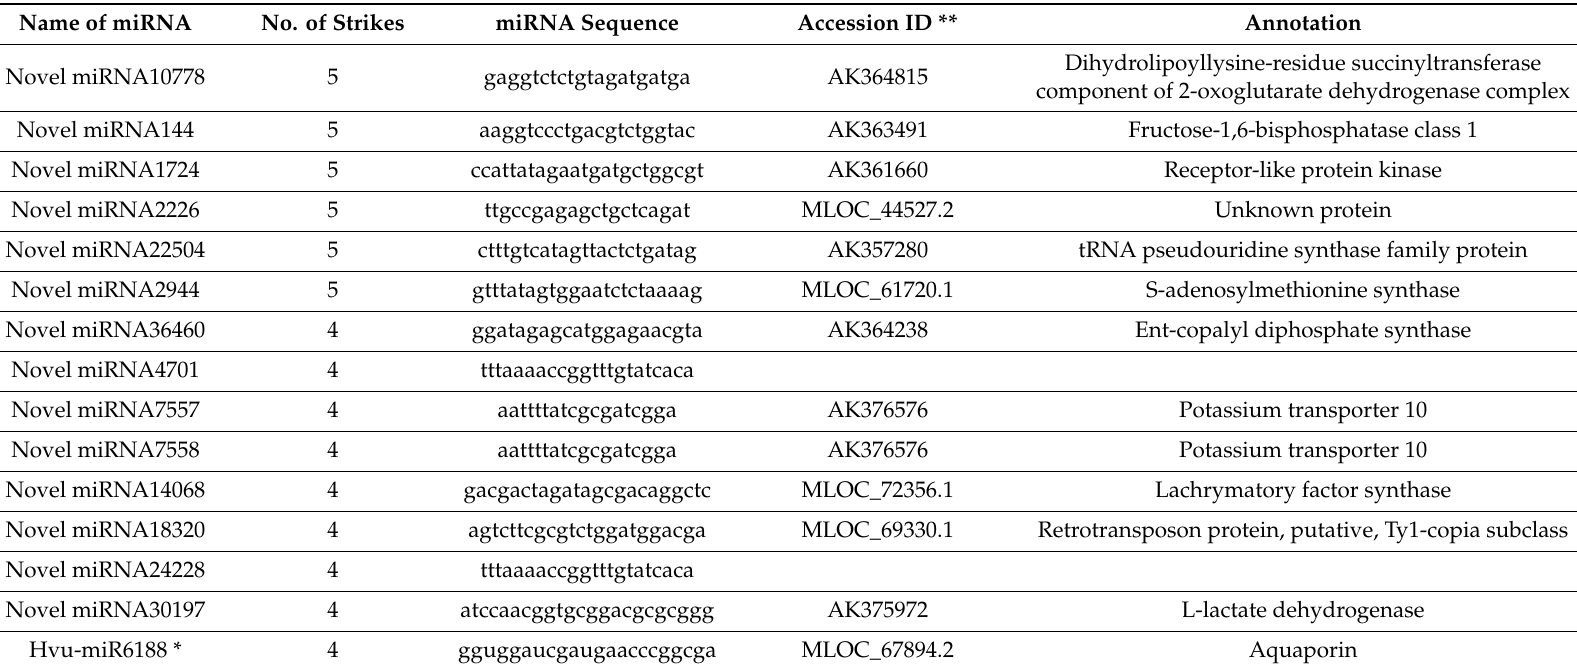
Table 3. miRNAs with the greatest changes in expression after BYDV